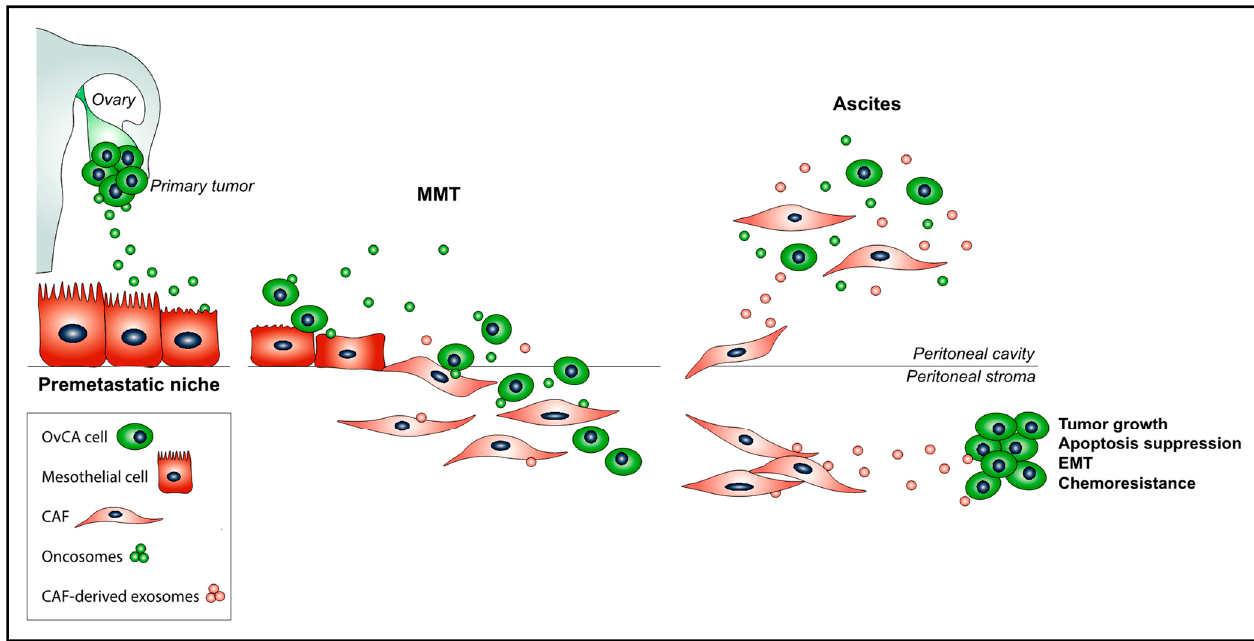
Figure 1. The promoting role of exosomes impinges on crucial steps of the OvCA peritoneal metastasis process: (i) Primary tumor-derived oncosomes educate a pre-metastatic peritoneal niche; (ii) during MMT, exosomes participate in the processes of adherence of OvCA cells to the mesothelium and co-invasion of OvCA cells and PMC-derived CAFs into the peritoneal stroma; and (iii) exosomes derived from CAFs induce EMT in tumor cells and suppress cancer cell apoptosis, as well as confer tumor growth and chemoresistance. Finally, OvCA cells, PMC-derived CAFs, and their, respectively, secreted exosomes are accumulated in the intraperitoneal ascitic fluid.